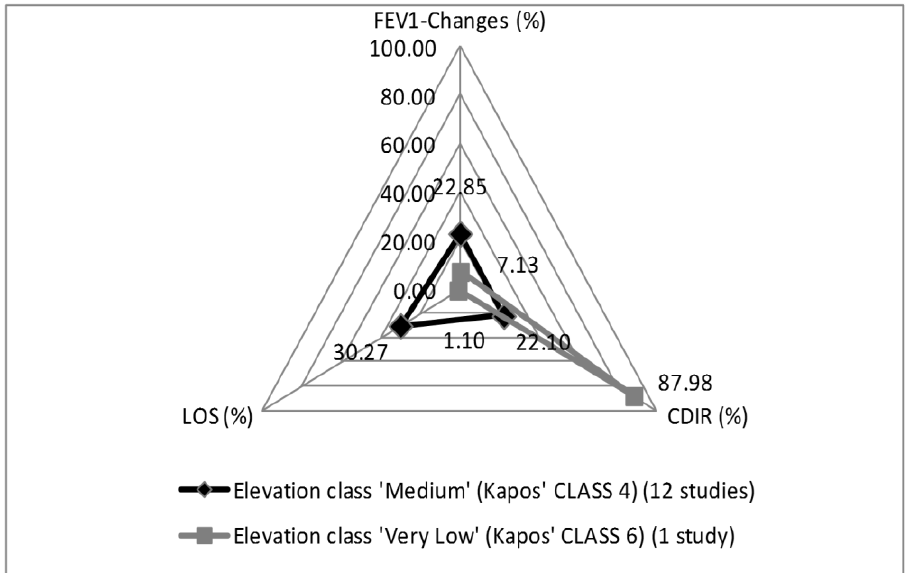
Figure 3. Positioning climate therapy stays considering Elevation class (Values standardized considering the maximum FEV1 Change (26.15%) and FEV1 Change CDIR (0.526%). Average values calculated by Duration classes, “Medium” and “Very Low”, as specified in Table